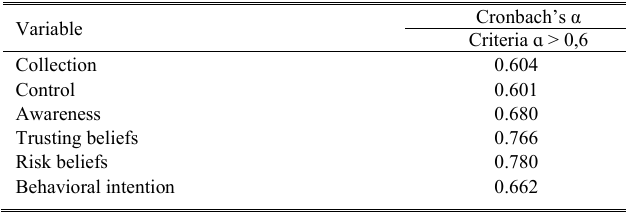
TABLE 2 R ELIABILITY T EST